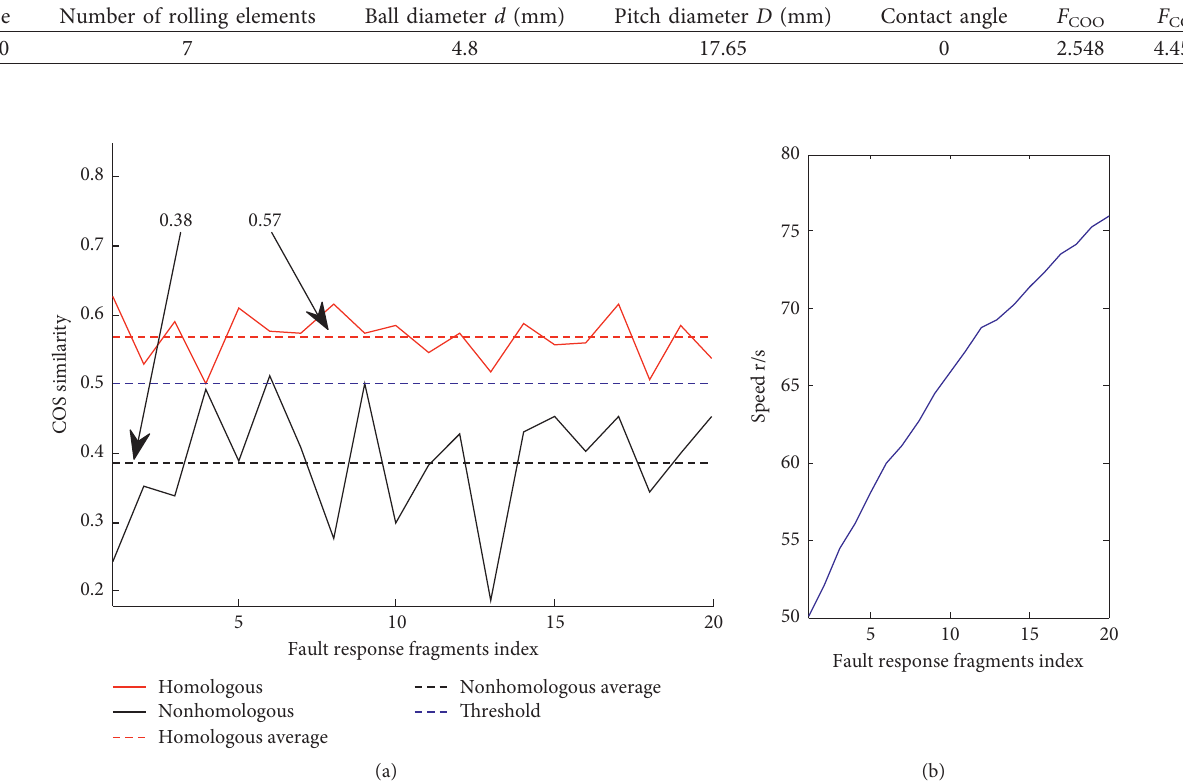
Figure 13: Response fragments’ mesh phase portraits. (a) Homologous mesh phase portraits. (b) Nonhomologous mesh phase